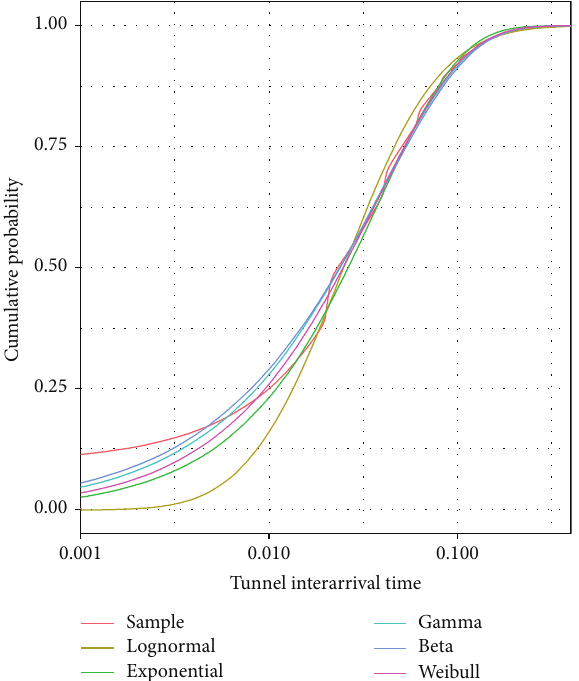
Figure 11: Empirical CDFs of the sampled interarrival time and fitted theoretical